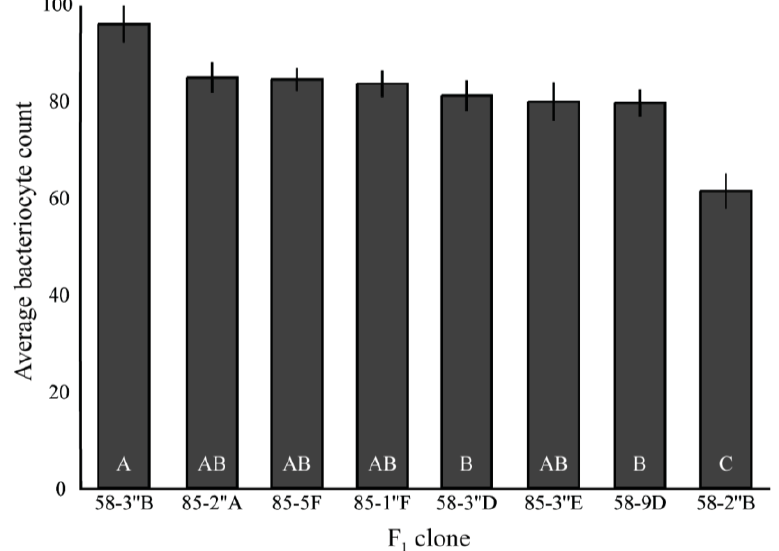
Figure S1. Average number of bacteriocytes from F are from the clone 5A matriline, while clones labeled 85 are from the 8-10-1 matriline. Clones exhibited significant differences F different let ters are significantly different (p < 0.05, Tukey’s HSD).